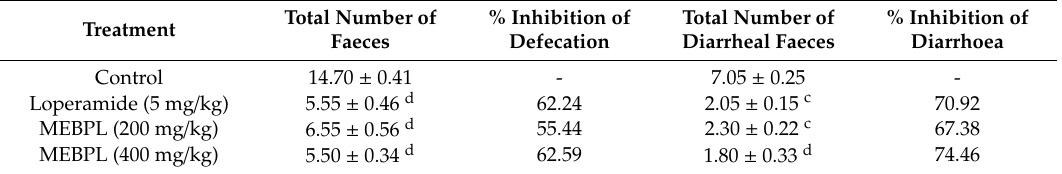
Table 5. The anti-diarrheal e ff ect of methanol extract of B. pilosa leaves (MEBPL) on castor-oil induced Swiss albino mice.